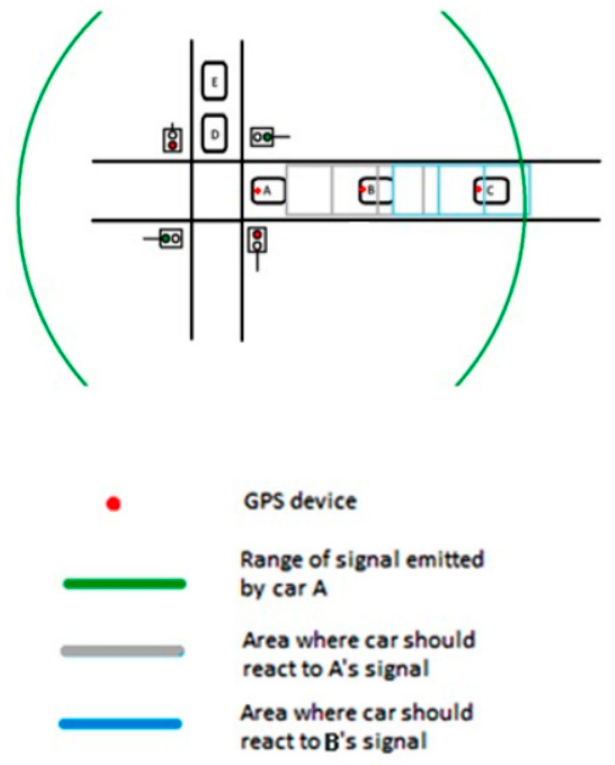
Figure 6. Algorithm working at intersection (simplified top view).